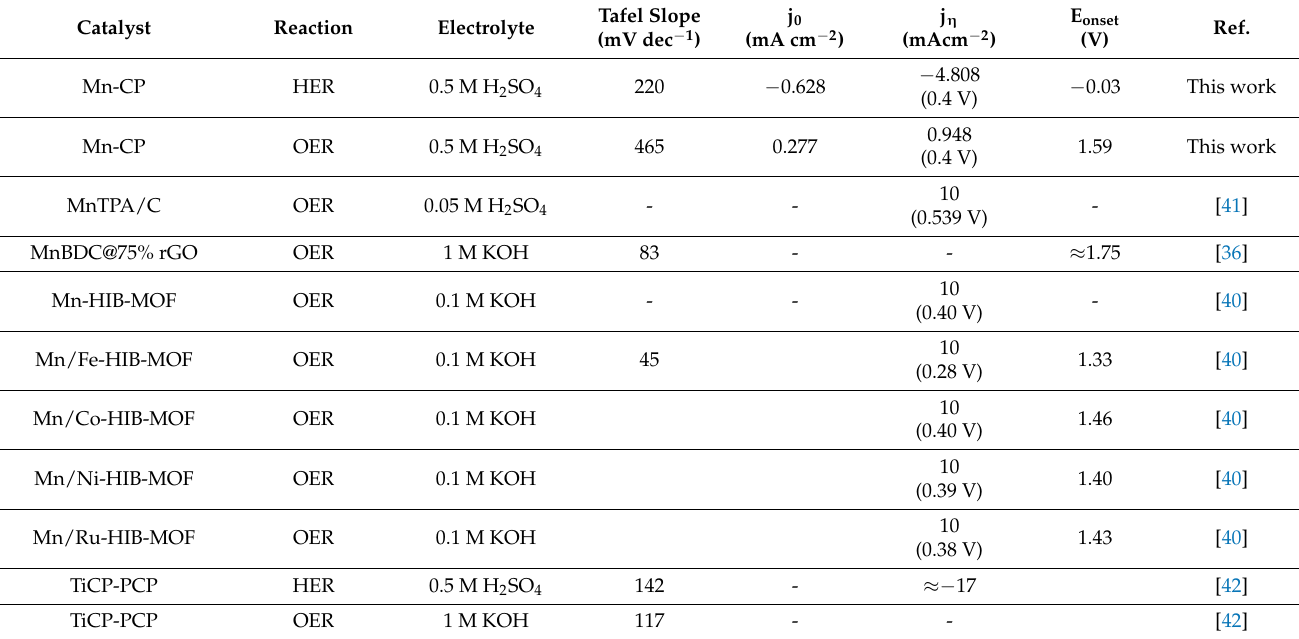
Table 2. Comparison of HER and OER parameters of the herein studied catalyst with ( Mn-CP ) literature data a .